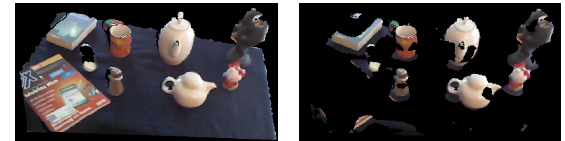
Figure 10: Point cloud before (left) and after (right) the persistent features computation